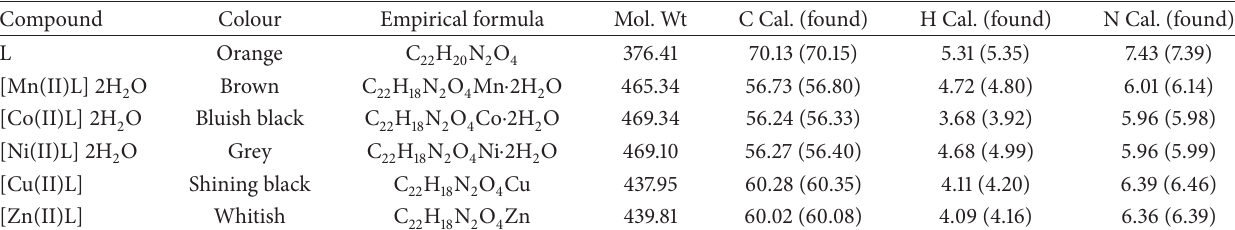
Table 1: Analytical and physical data of the compound